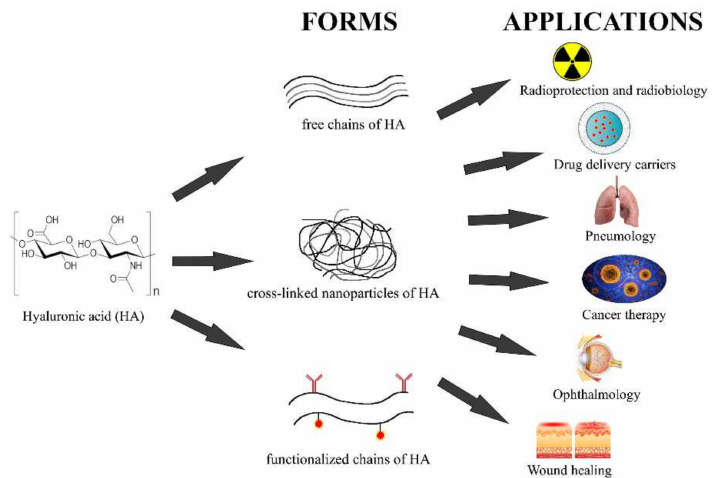
Figure 4. Applications of hyaluronic acid. Different forms of chemically modified HA—native, cross- linked or functionalized are used in pharmaceutical, medical, cosmetic, and research